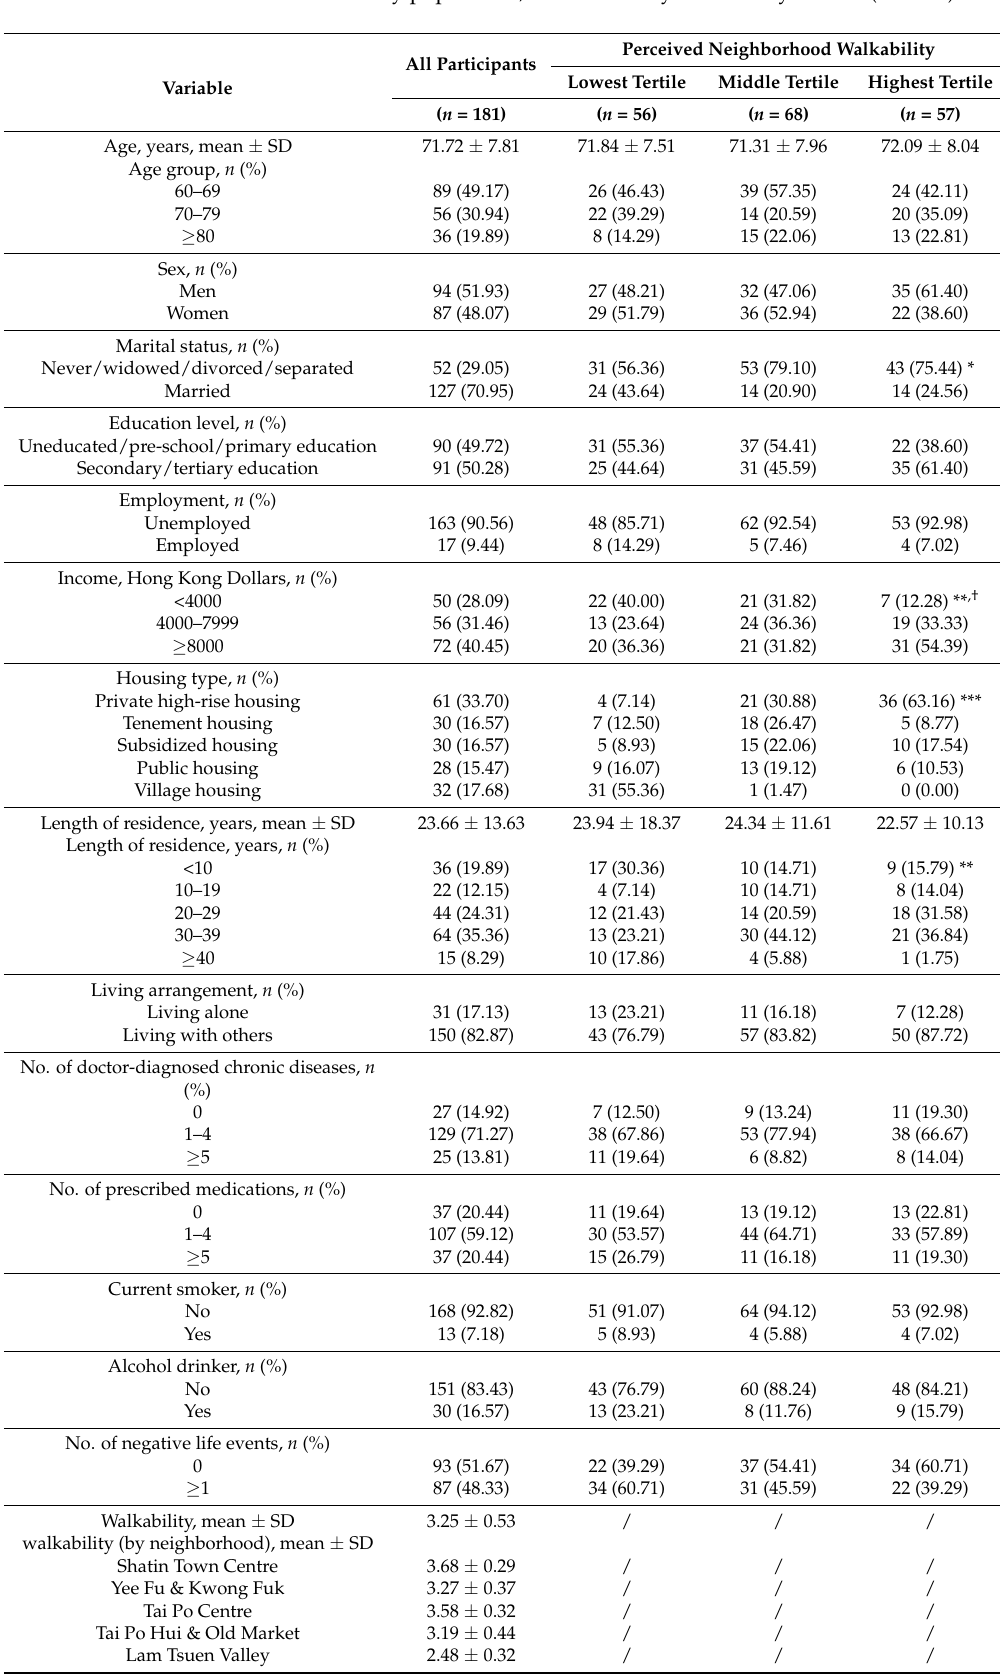
Table 1. Characteristics of the study population, overall and by walkability tertiles ( n = 181). Perceived Neighborhood All Participants Variable